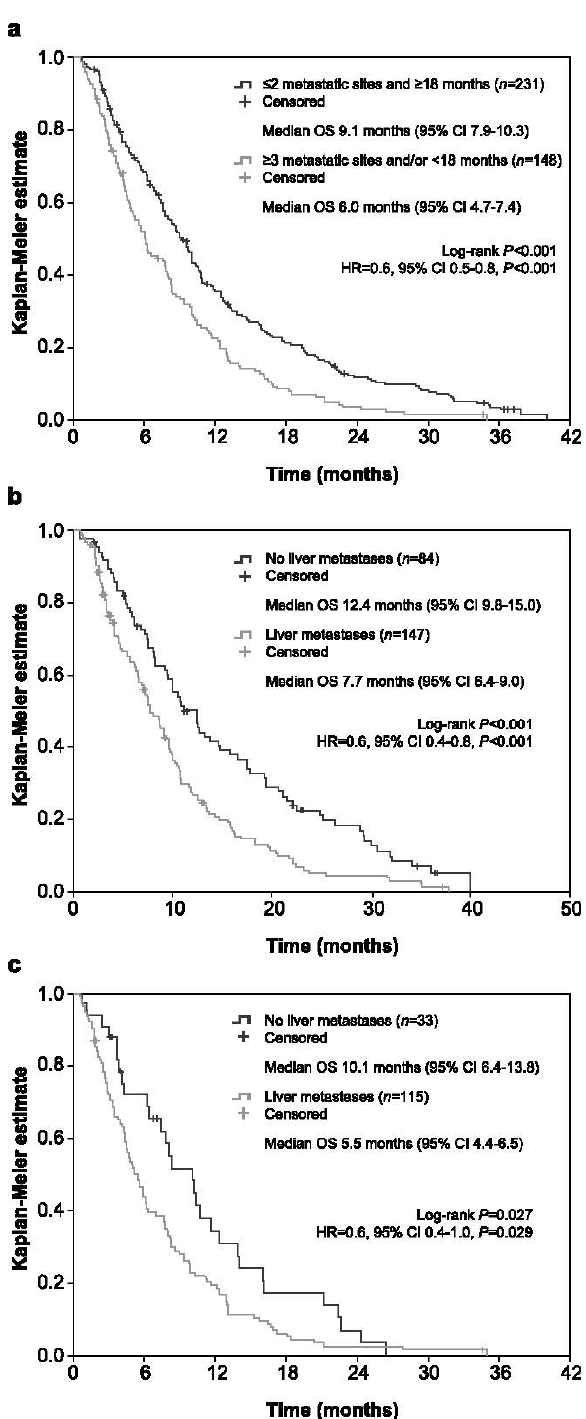
Figure 2. Kaplan–Meier plots for overall survival in the exploratory analysis of prognostic subsets. They included the comparison of patients with ≤ 2 metastatic sites and ≥ 18 months from metastasis diagnosis versus those with ≥ 3 metastatic sites and/or <18 months ( a ), patients with ≤ 2 metastatic sites, ≥ 18 months from metastasis diagnosis and absence of liver metastasis versus those with ≤ 2 metastatic sites, ≥ 18 months from metastasis diagnosis and liver metastasis ( b ), and patients with ≥ 3 metastatic sites and/or <18 months from metastasis diagnosis and absence of liver metastasis versus those with ≥ 3 metastatic sites and/or <18 months from metastasis diagnosis and liver metastasis ( c ). CI: confidence interval, HR: hazard ratio, OS: overall survival. The median PFS measured until radiologic disease progression or death was 3.2